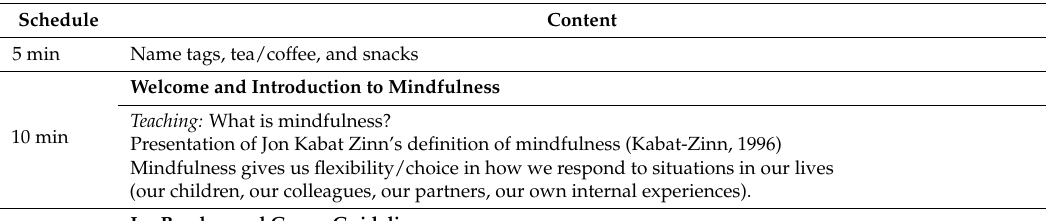
Table 1. Content of Parent Mindfulness